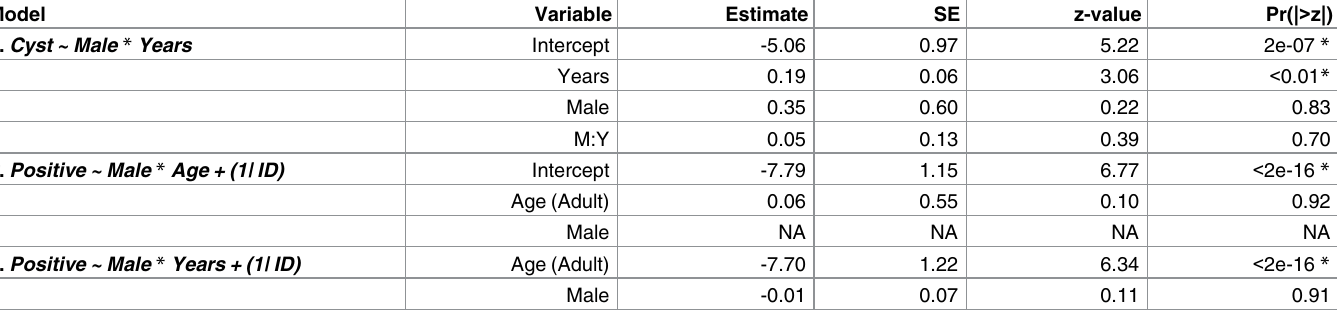
Averaged parameter estimates, adjusted standard errors (SE), z-values, and probability estimates (Pr ( > |z|) are presented for all predictor variables in each model. Results are presented for both full model averagingand conditional averaging, and are rounded to the nearest hundredth. Statistical significance is marked by an asterisk ( * ).